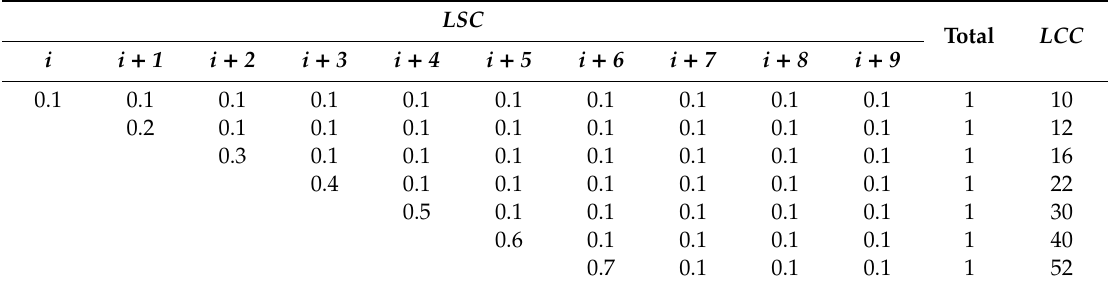
Table 1. Variations in the land cover continuity (LCC) indicator resulting from the number